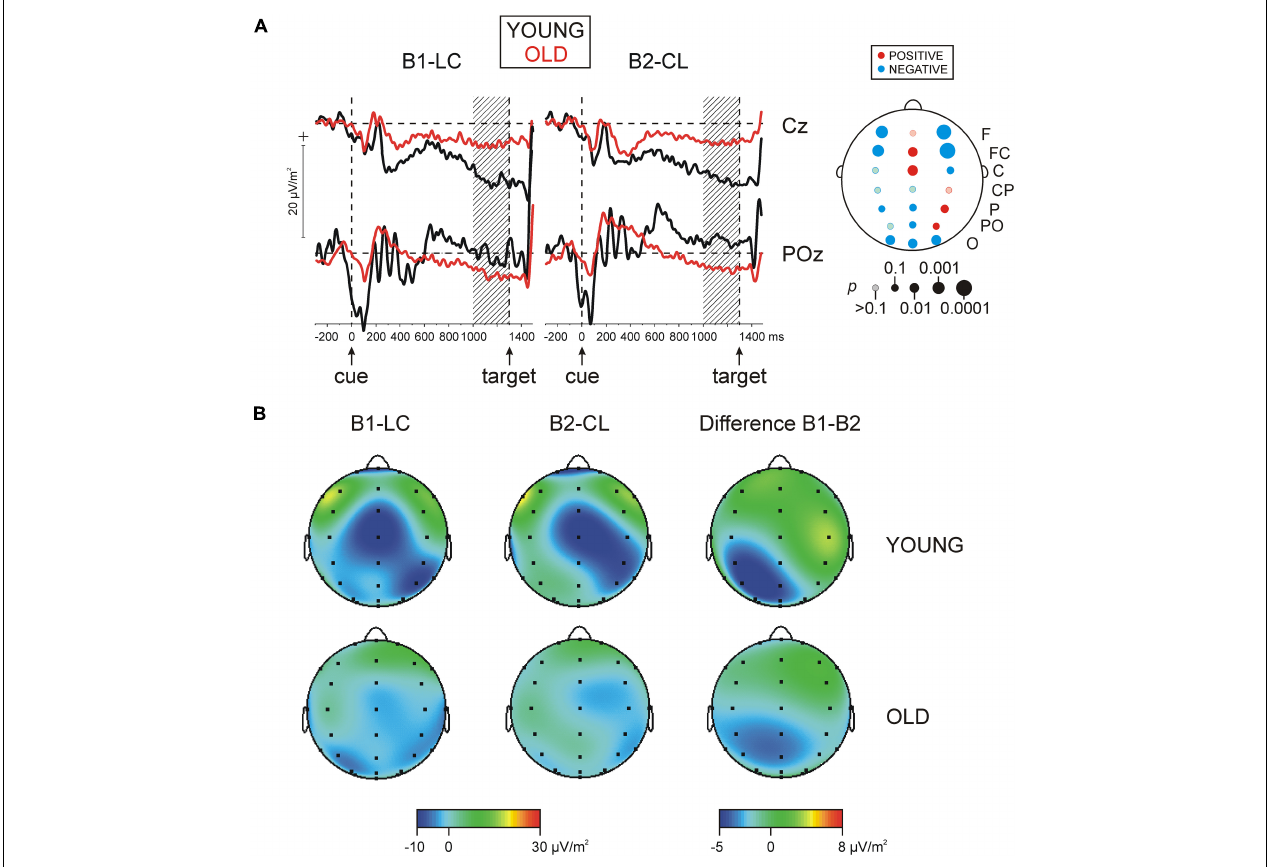
FIGURE 3 | (A) Grand average of slow cortical potentials (SCPs) for two groups, young and old, for two blocks, block 1 (B1-LC), and block 2 (B2-CL) at electrodes Cz and POz (band pass 0.03-30 Hz). Statistical significance of difference in SCPs between groups of young and old subjects is presented in the map on the right side. p , statistical significance; red (negative SCPs young > negative SCPs old), blue (negative SCPs old > negative SCPs young). (B) Grand average maps of the distribution of SCPs for the same two blocks and for the B1–B2 difference in young and old adults.